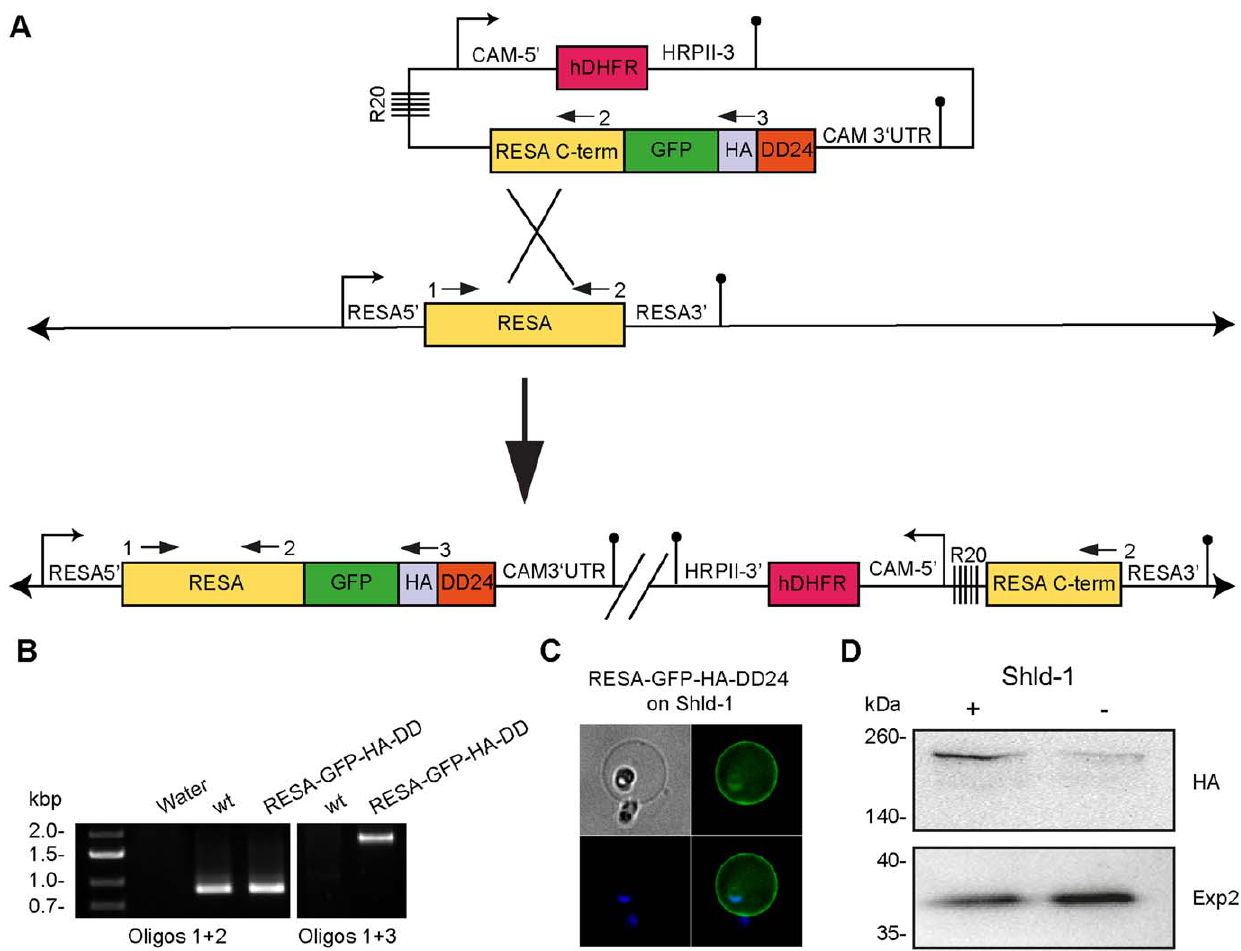
Figure 4. DD can be used to regulate exported proteins. (A) Diagram of DNA integrations into the RESA locus to produce the transgenic line. After integration in the presence of Shld-1, RESA was expressed in fusion with the GFP-HA-DD24 under the control of the native RESA promoter. (B) Integration of the plasmid in the RESA endogenous locus is confirmed by PCR. The oligonucleotides used are indicated by arrows in (A). (C) Fluorescent microscopy of live parasites labelled with DAPI showing RESA-GFP-HA-DD24 is exported to the RBC membrane. (D) Western blot analysis of RESA-GFP-HA-DD24 transfectants showing that RESA levels decrease after the removal of Shld-1. Parasites integrated in the presence of Shld-1 at ring stage were split and kept either with 0.5 m M or no Shld-1 for 2 days when RBC ghosts were collected and protein were fractionated by SDS-PAGE. The western blot was probed with anti-HA mAb to detect RESA-GFP-HA-DD24. As the loading control, the western blot probed with polyclonal rabbit anti-Exp2 [31].